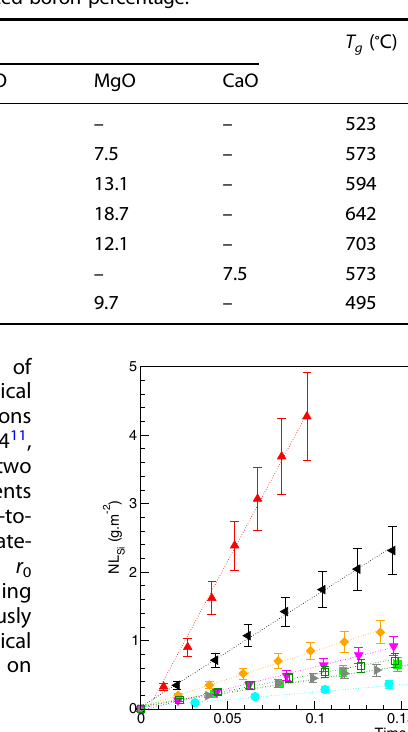
Fig. 1 Time dependence of normalized mass loss (NL) based on Si release obtained at pH 90 °C = 9 and T = 90 °C for all the studied glasses. Dashed lines represents the linear regression. Uncertainties on NL based on silicon concentration for a given test are given at ± 15% based on instrumental measurements. Overall uncertain- ties r 0 determination are given at ±